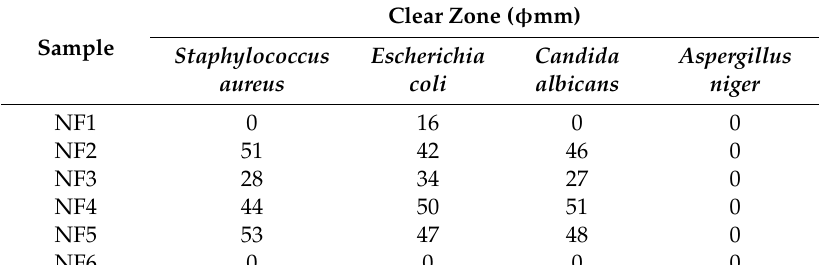
Table 4. E ff ects of nanoformulations on the zones of inhibition of selected microbes.